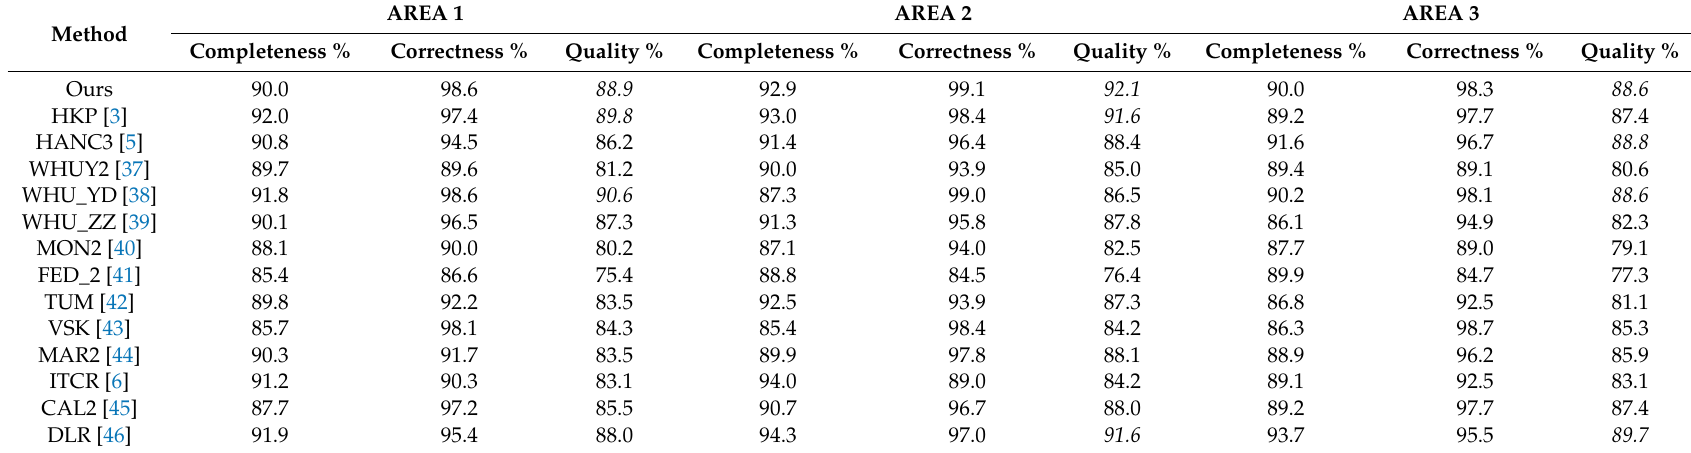
Table 4. Evaluations of the semantic labeling results in three Vaihingen sites using the proposed method and the quantitative comparison with other methods. AREA 1 AREA 2 AREA Method